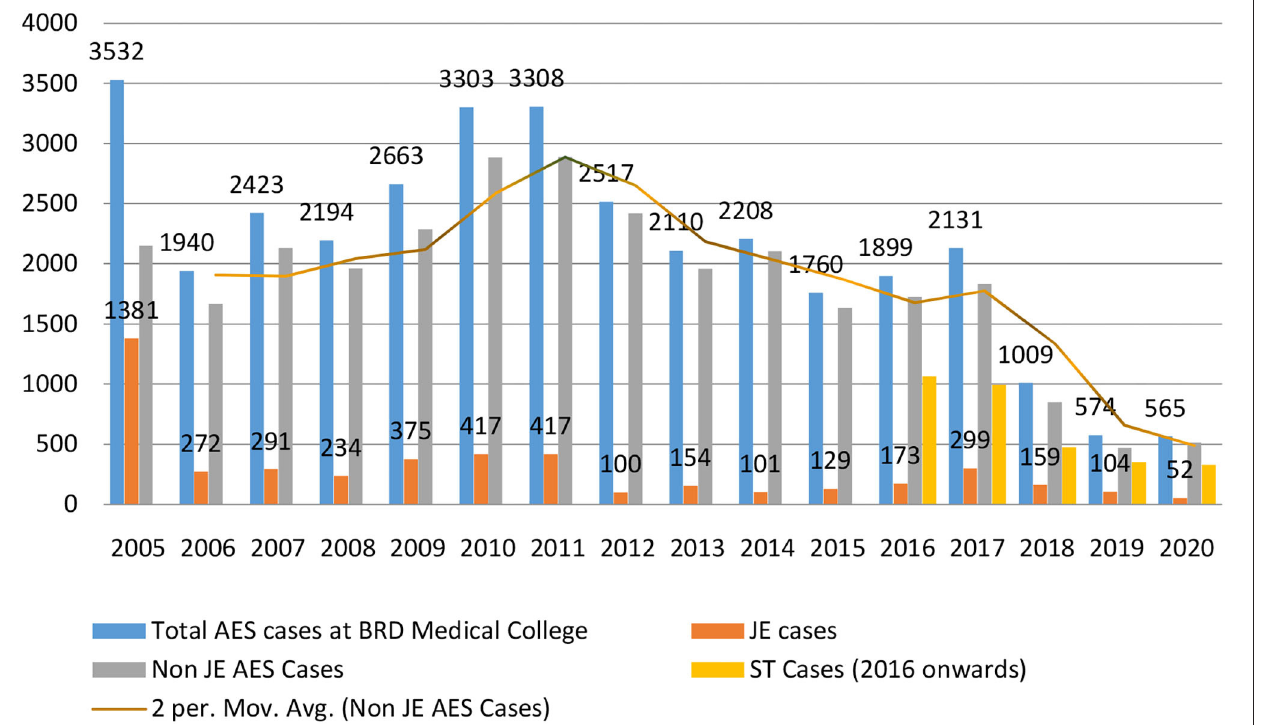
FIGURE 2 | Decline in burden of AES cases due to Japanese encephalitis (JE), non-JE AES, and scrub typhus at BRD medical college, Gorakhpur.